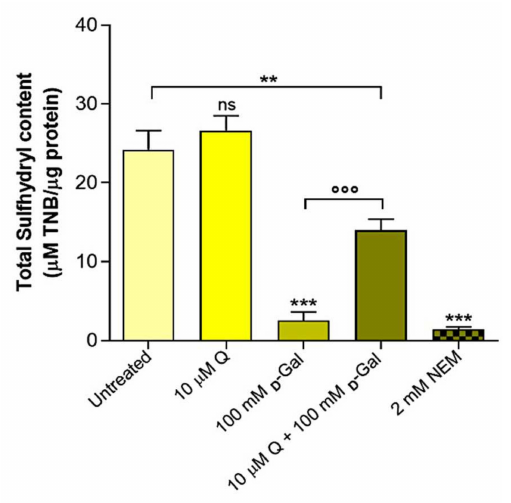
Figure 5. Sulfhydryl group content ( µ M TNB/ µ g protein) in untreated erythrocytes (control) and in erythrocytes treated with 100 mM D -Gal for 24 h with or without 10 µ M Q (pre-incubation for 1 h), or alternatively, with 2 mM NEM or 10 µ M Q for 1 h. ns, not statistically significant versus control; **, p < 0.01 and ***, p < 0.001 versus control; ◦◦◦ , p < 0.001 versus 100 mM D -Gal, one-way ANOVA followed by Bonferroni’s multiple comparison post hoc test ( n =